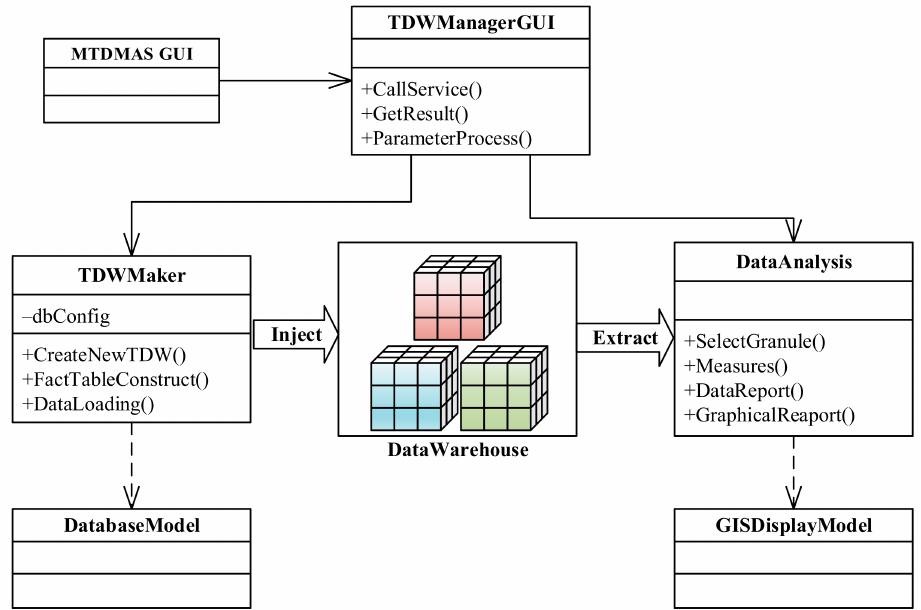
Figure 7. Class diagram of the situation analysis